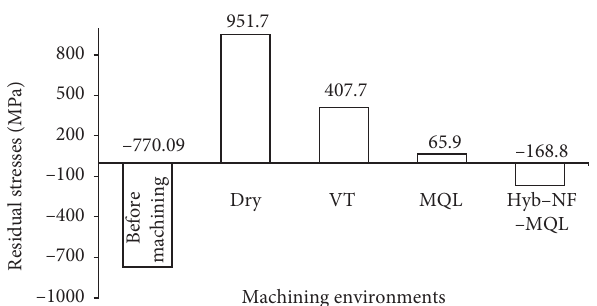
Figure 9: Effect of machining environments on residual stresses at cutting speed, 200m/min and feed,